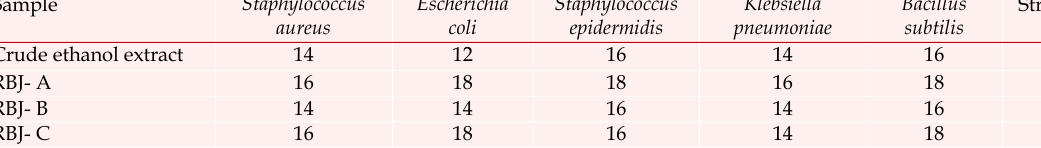
Antimicrobial results for crude and fractions